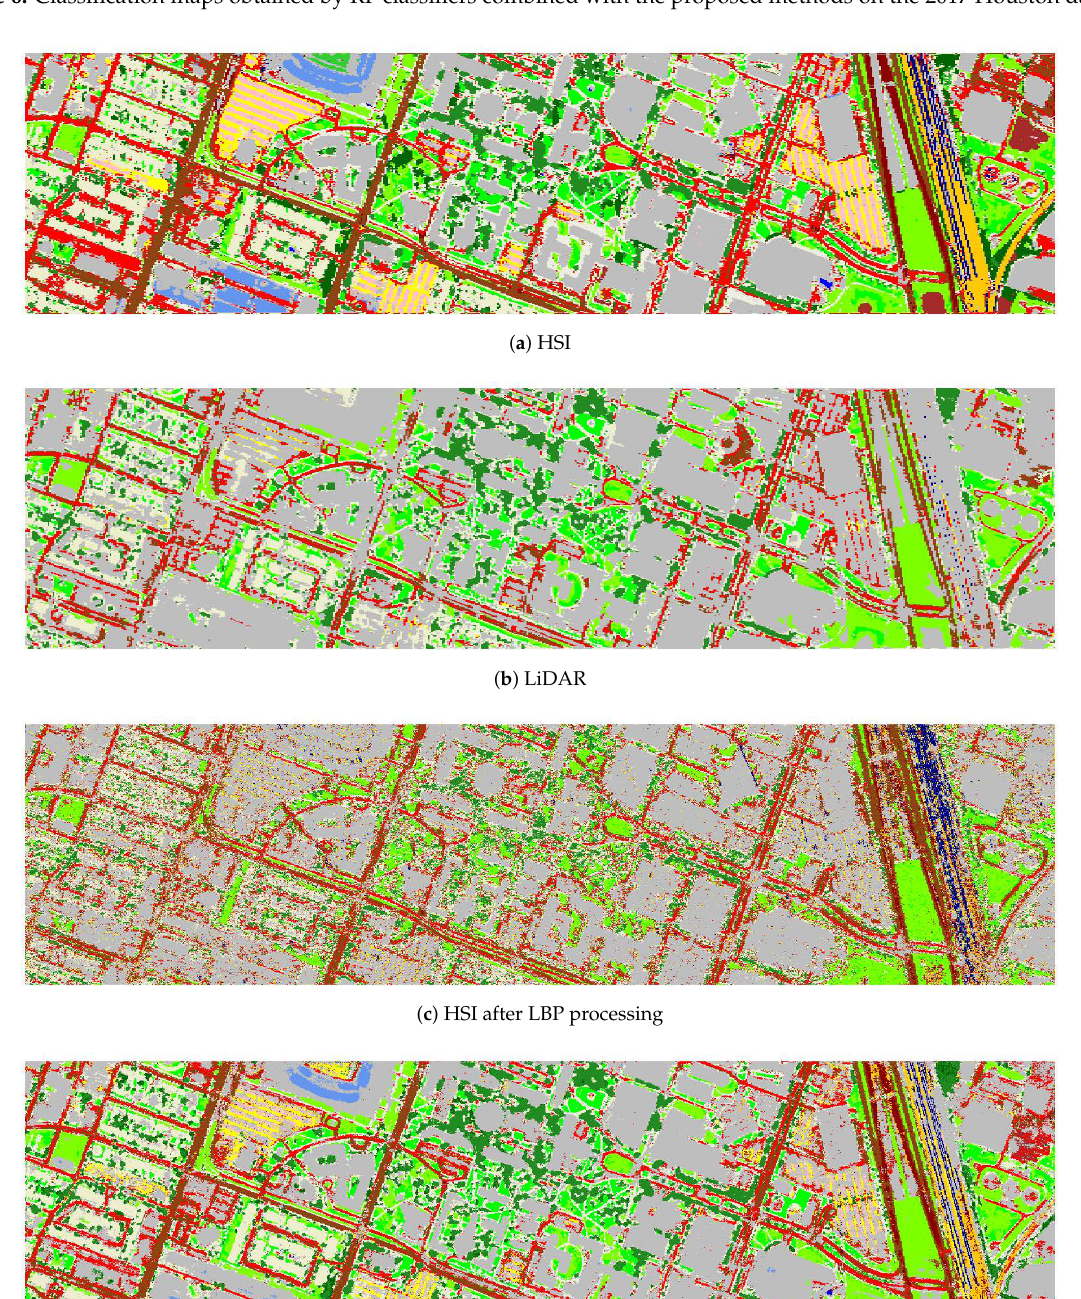
Figure 6. Classification maps obtained by RF classifiers combined with the proposed methods on the 2017 Houston dataset.